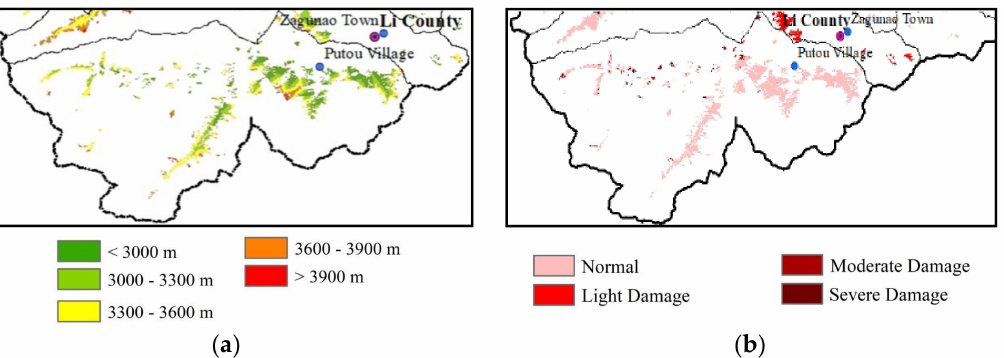
Figure 10. The relationship between altitude and Lophodermium piceae : ( a ) the altitude distribution of Putou Village; ( b ) the disease-investigation results of Putou